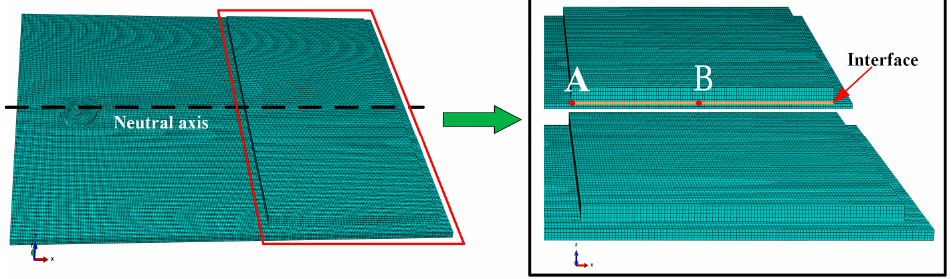
Figure 4. FE mesh and reference points (A and B) of the deicing system for the FE parametric study.